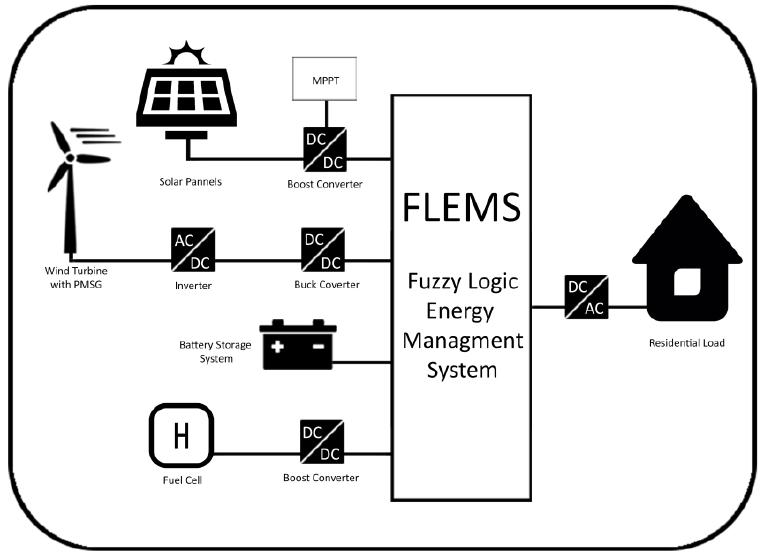
Figure 1. Basic structure of the proposed direct current (DC) DC standalone microgrid in the first stage.